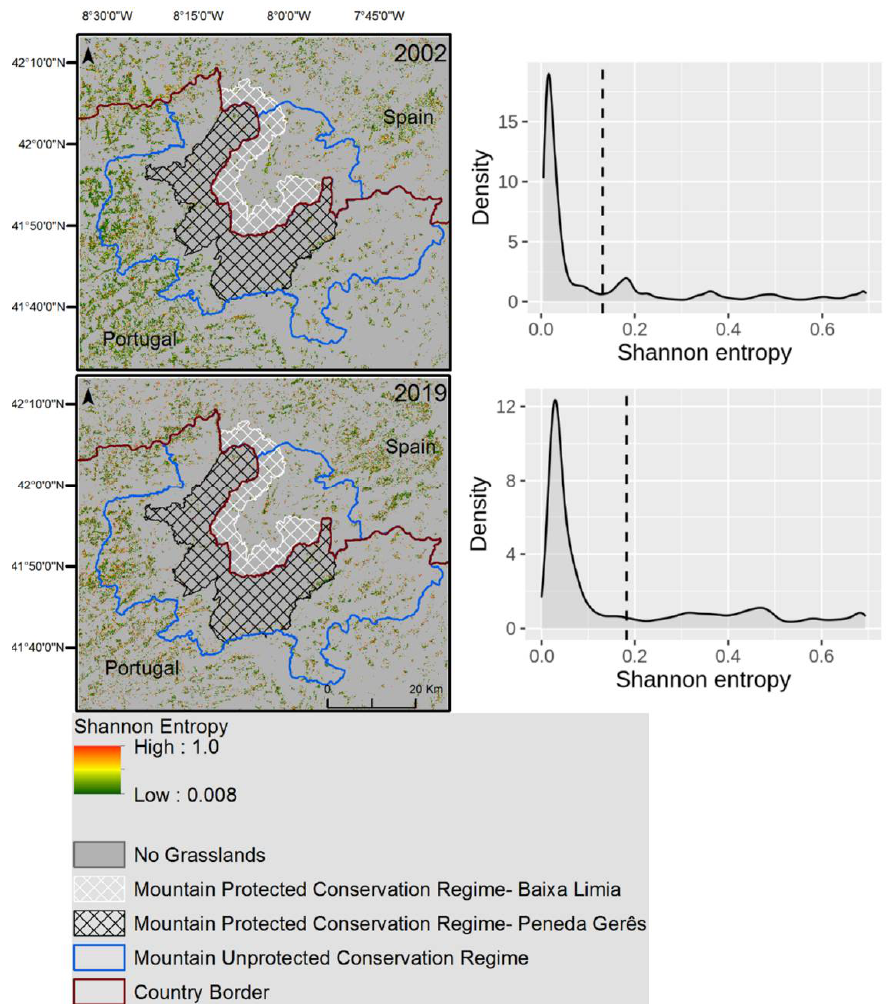
Figure 6 . Uncertainty in the grassland pixel class assignment during the classification stage (2002, 2019). Uncertainty was estimated with the Shannon entropy and the probability layers of grassland/no grassland created during the classification stage. Left panels show uncertainty for each pixel classified as grasslands (30 m resolution) in a green-to-red colour gradient. Right panels represent the frequency distribution of uncertainty across grassland pixels, with the dashed line indicating the mean values.